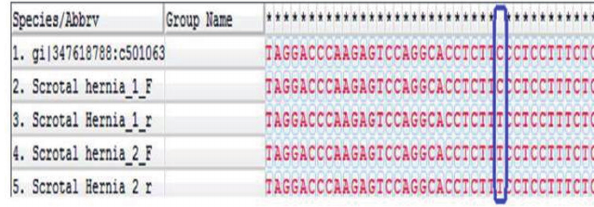
Figure 2. DNA Alignment of the positive controls of scrotal hernia showing the cytosine to thymine mutation at the 119th base of the BCL2-associated X protein (BAX) gene.